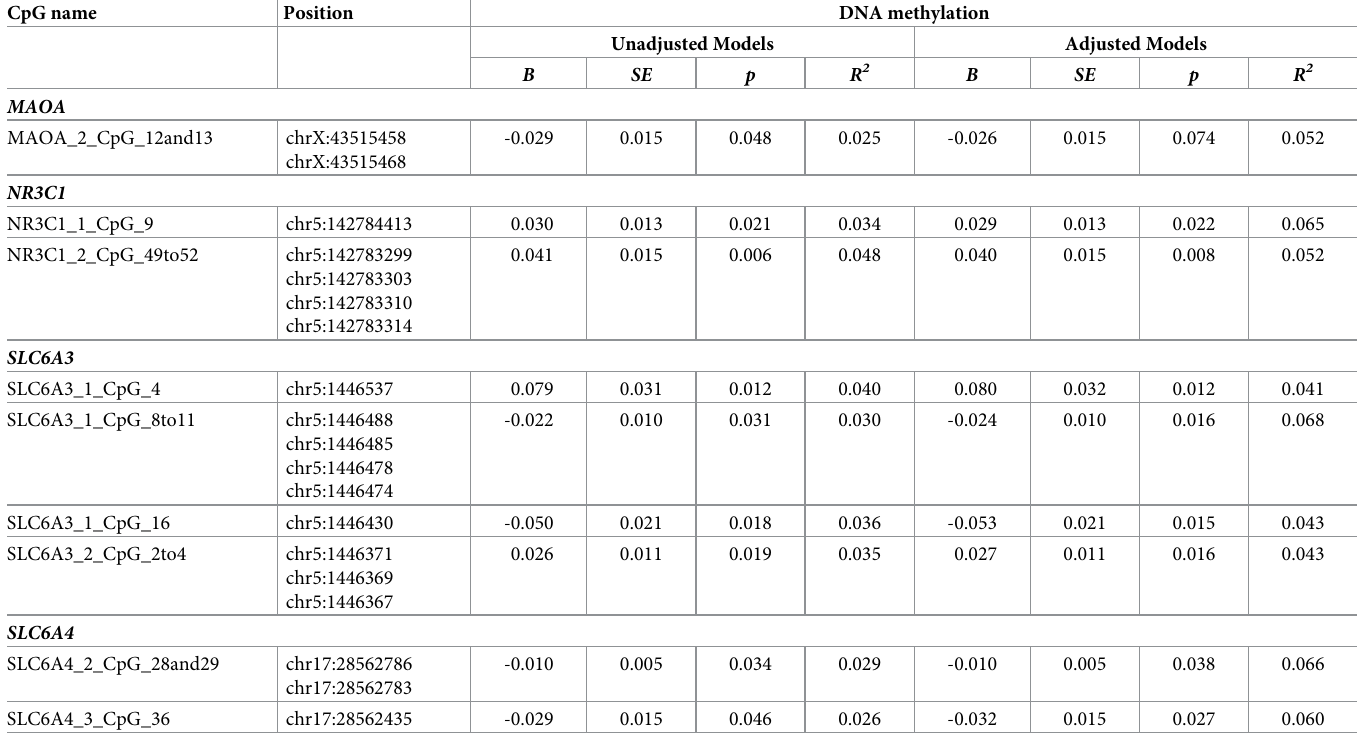
Table 1. Significant associations between child maltreatment and DNA